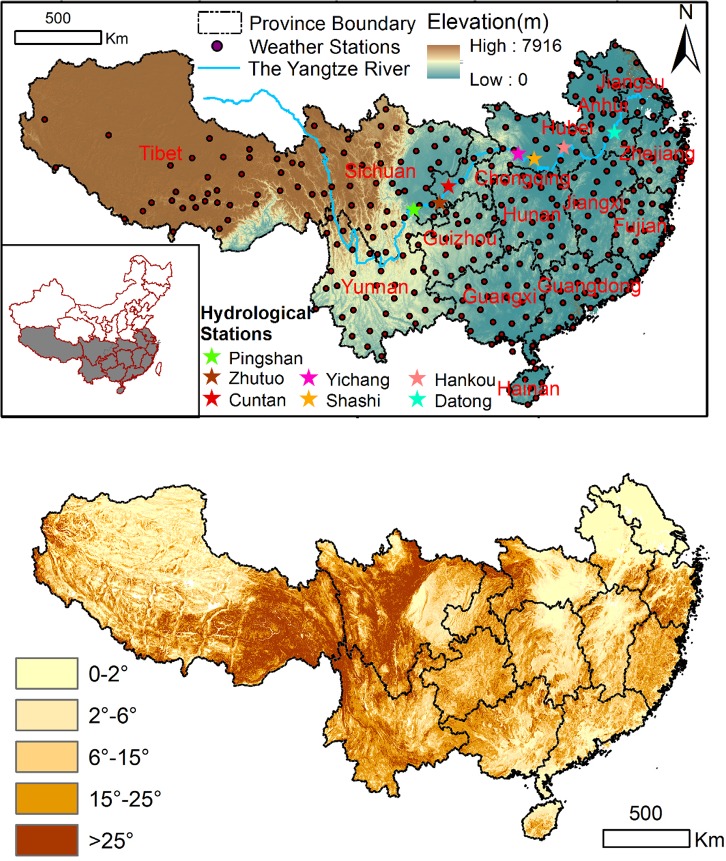
The elevation map, locations of meteorology and hydrological stations (above) and slope distribution in southern China (below).